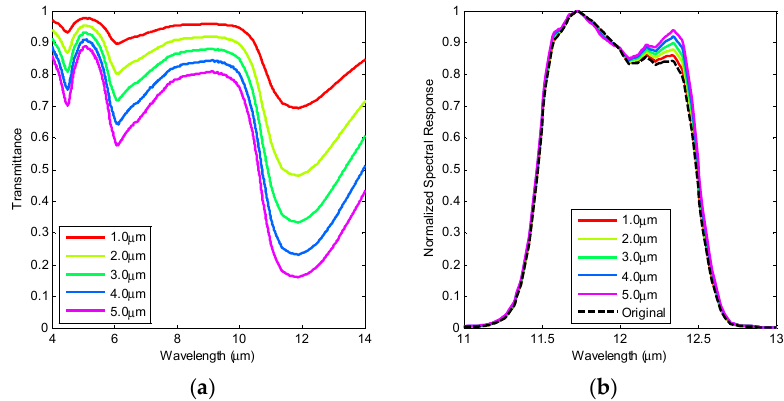
Figure 6. SRF variations of the FY-2G IR2 band caused by ice contamination with possible ice-layer characteristics. ( a ) ITS with different ice-layer thickness; and ( b ) convolved SRFs with different ITSs. Table 2. Statistical results of SRF ITS impact on the central wavelength and bias of the FY-2G IR2 band.